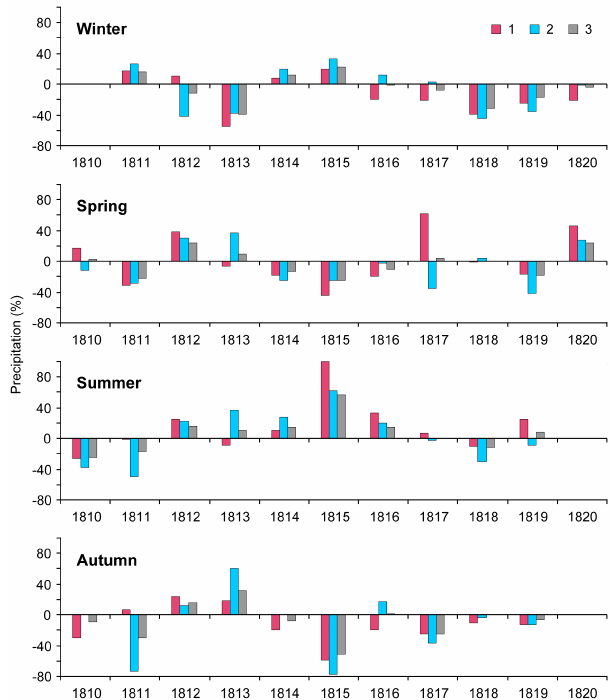
Figure 5. Seasonal precipitation anomalies in Prague- Klementinum (1), Brno (2) and Czech Lands (3) series around the time of Tambora eruption in 1815. Anomalies are expressed with respect to the 5-year period pre-eruption: month zero – April 1815.